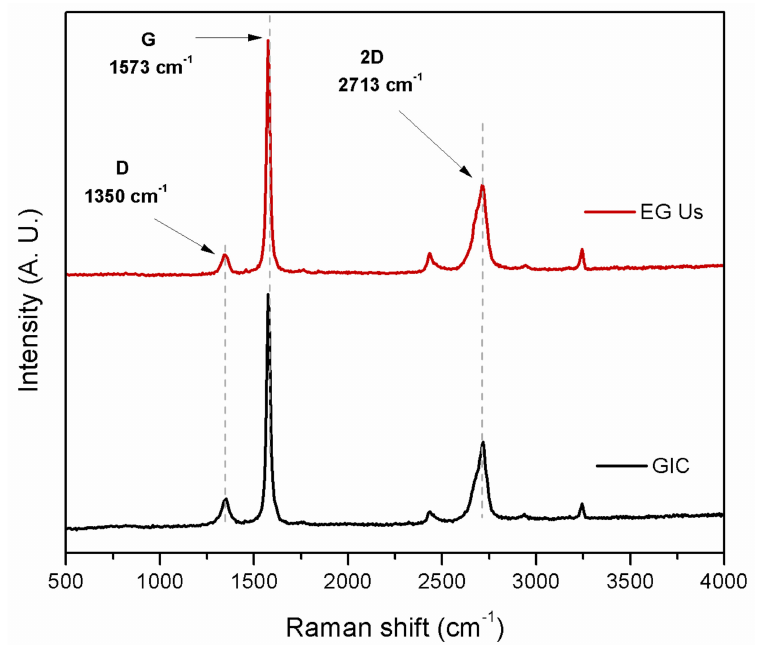
Figure 3. Raman spectra for GIC flakes and EG obtained after ultrasound